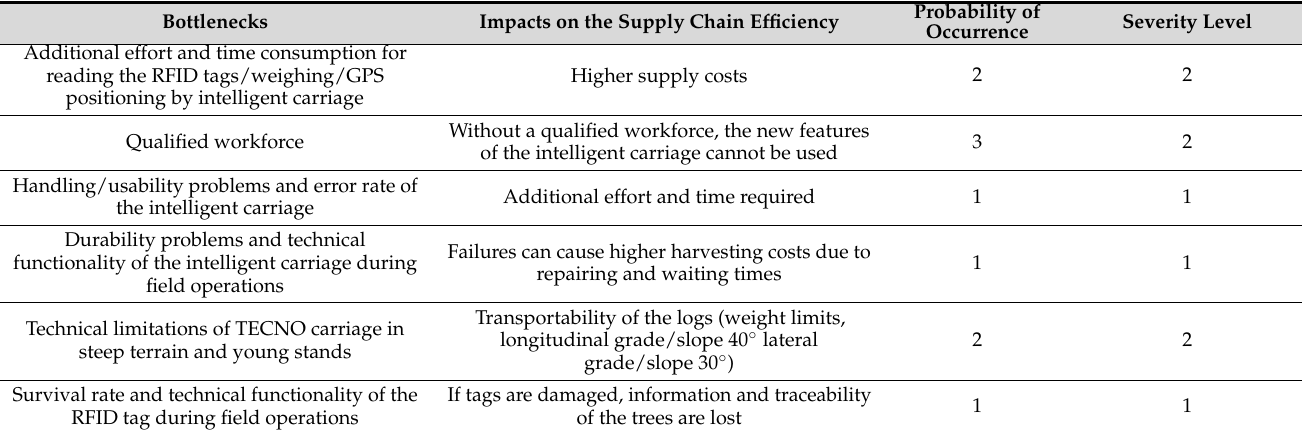
Table 7. Bottleneck and risk analysis of extracting the trees by intelligent carriage. Scale classes: low (1), moderate (2), and high (3).